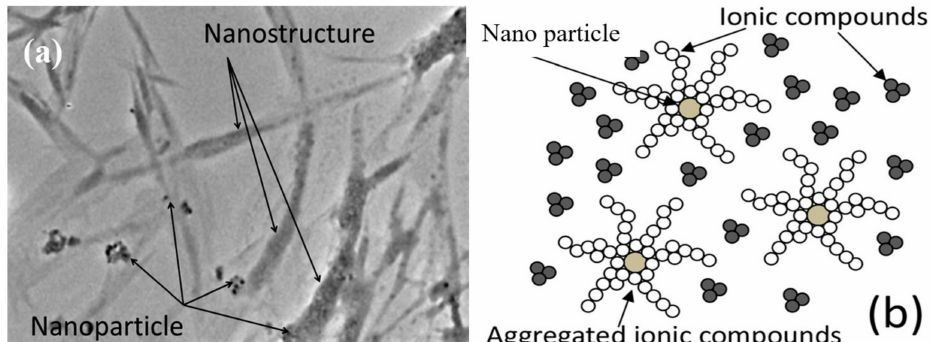
Figure 5. Nanostructures are grown from each nanoparticle and connect each other to form fractal- like fluid nanostructures. ( a ) TEM image of fractal-like fluid nanostructures formed in a molten salt nanofluids by separated base molten salts; ( b ) corresponding schematic illustration